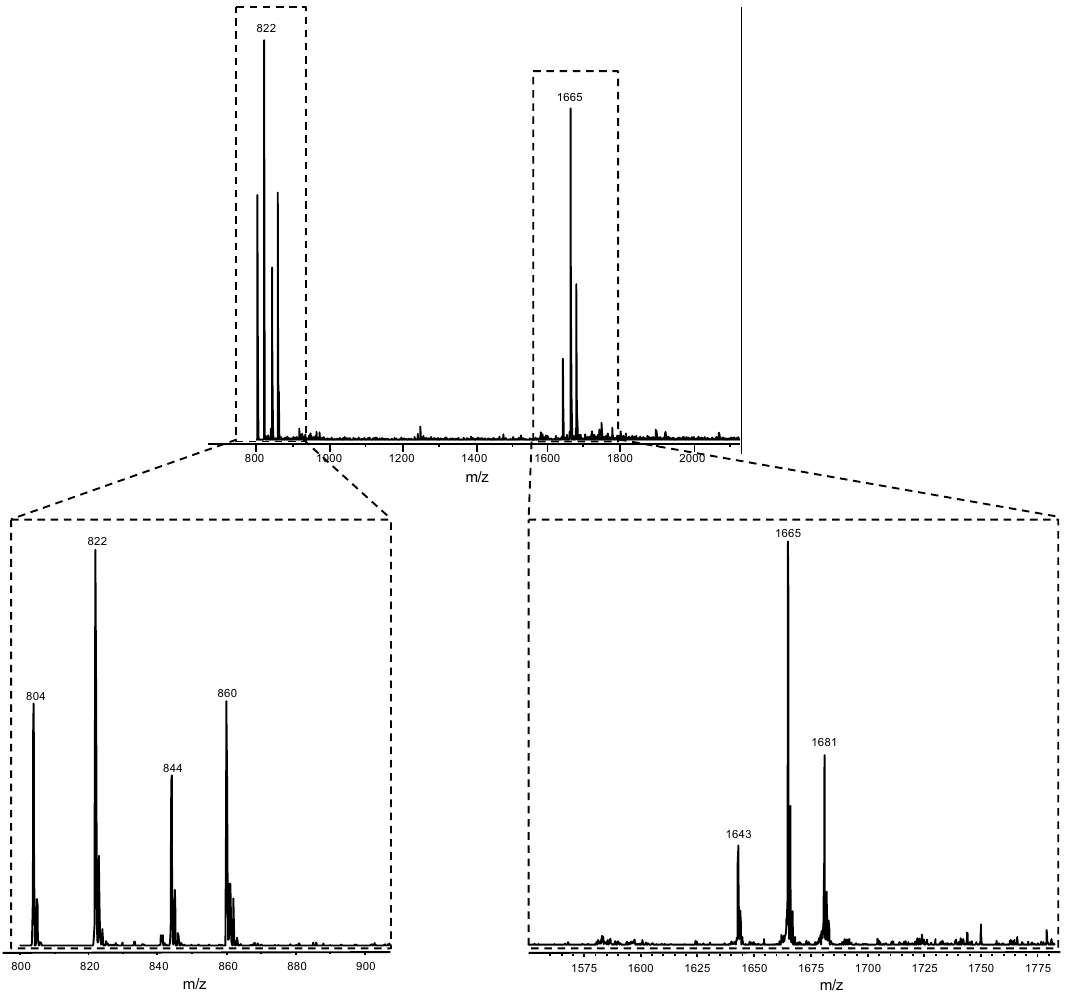
Figure 4. ESI positive-ion mass spectrum of the new compounds detected; those with retention times between 12 and 15 min are shown in Figure 1.